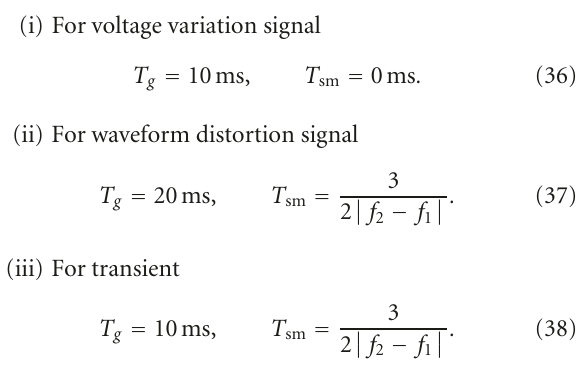
Figure 8: Process flow of the adaptive optimal